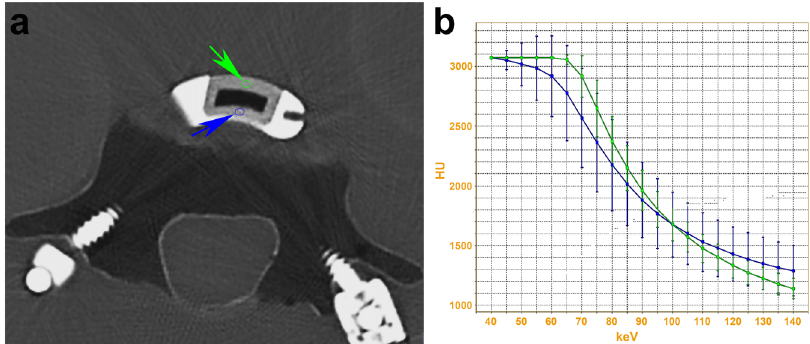
Fig. 3 Example of energy-dependent density (attenuation) changes of the titanium cage lattice using dual-energy CT (DECT). a Axial image demonstrates two regions of interest (ROIs) with the corresponding ( b ) spectral Houns fi eld Unit attenuation curves (SHUACs). ROIs are used to obtain quantitative information from the image. The small circles represent the ROIs (to which the arrows point) and correspond to the regions where the measurements were obtained. The information obtained from the ROIs is illustrated in the corresponding SHUACs,